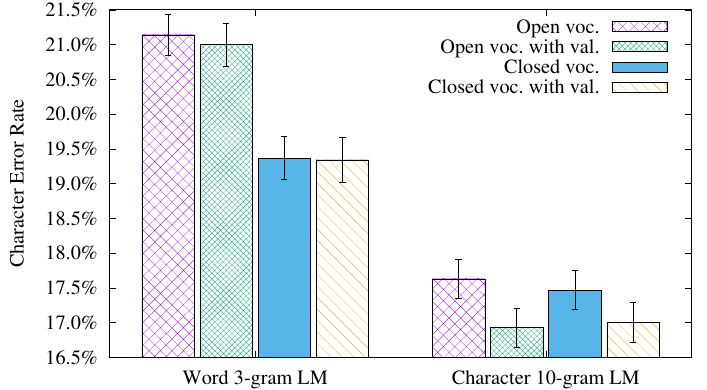
Figure 11. CER results obtained by the best word-based HMM system and the best character-based HMM system with open and closed vocabulary, with and without using the validation samples for training the LM.